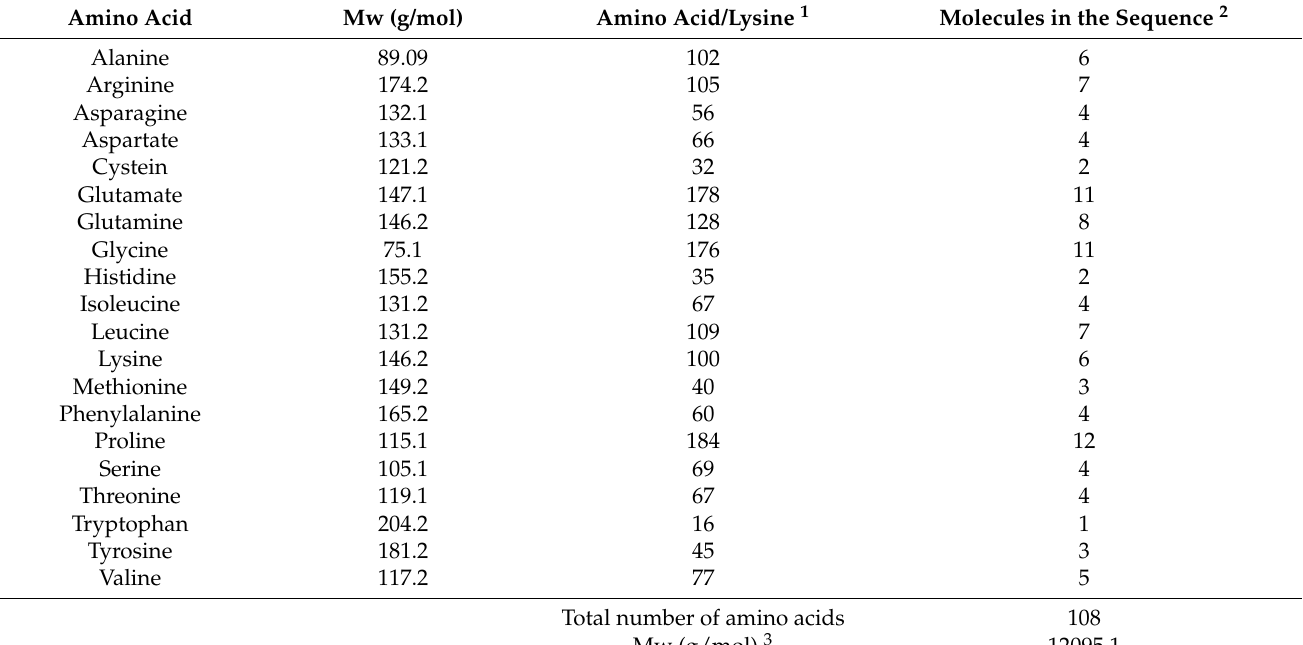
Table 3. Amino acid requirements (expressed relative to lysine, lysine = 100) for chickens from 0 to 21 days used for protein